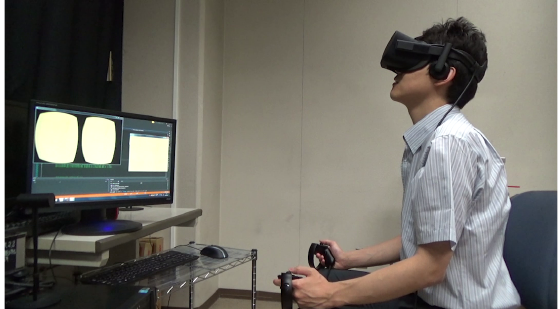
Figure 14. Experimental